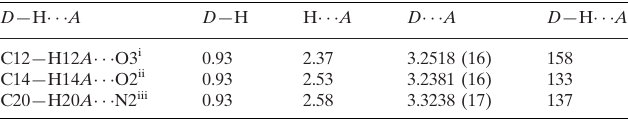
Hydrogen-bond geometry (A˚ , (cid:2)